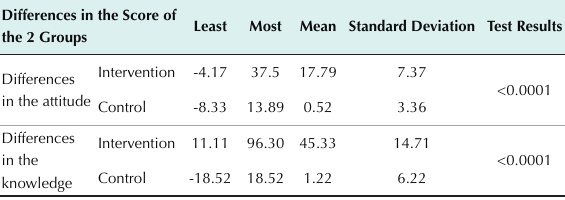
Table 3. The Comparison of Participants’ Knowledge and Attitude Difference Before and After the Intervention About Sex During Pregnancy Between the Intervention and Control Groups Differences in the Score of the 2